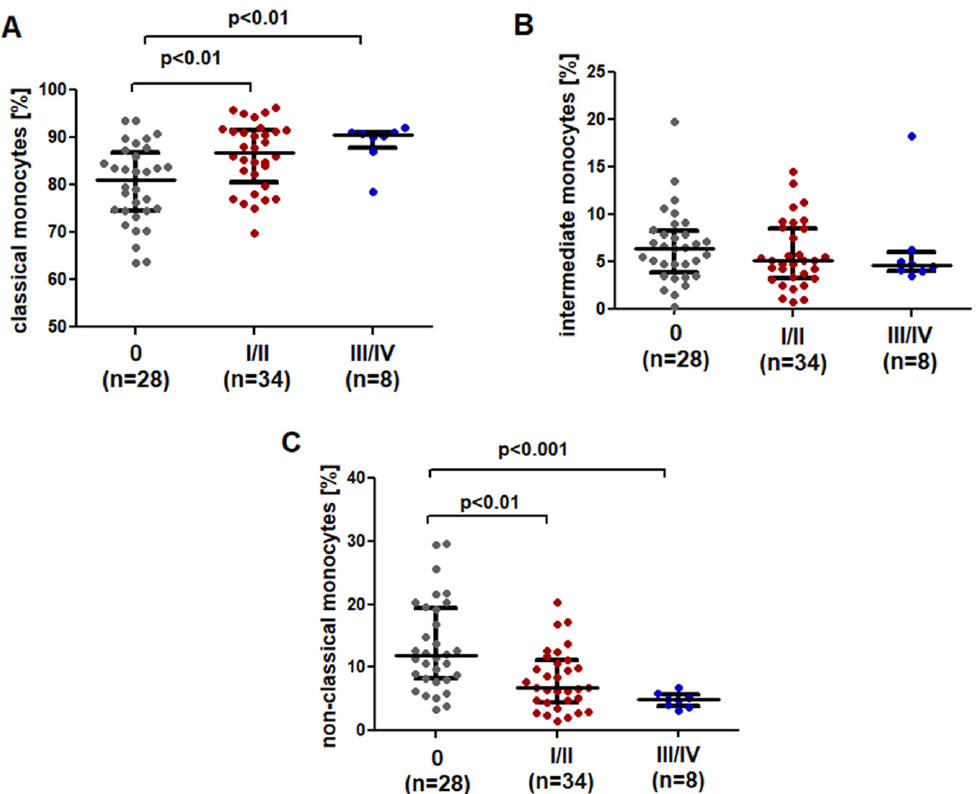
Figure 3. Comparison of the percentage of ( A ) classical, ( B ) intermediate and ( C ) non-classical monocytes in CLL patients at different stages of disease advancement. The solid line marks the median value. Ɪ represents the interquartile range (IQR).